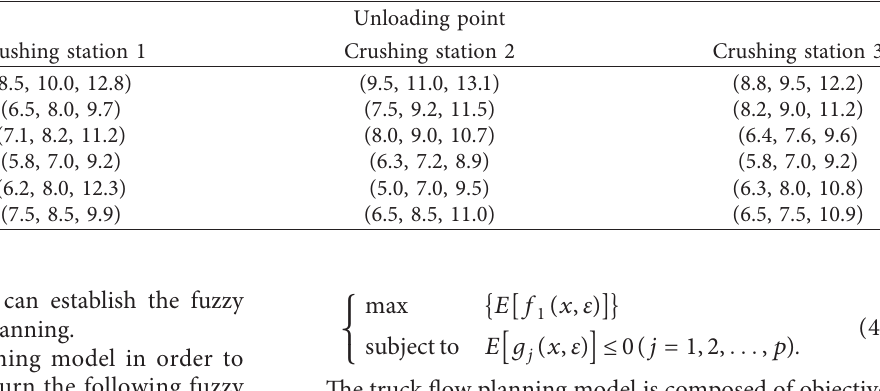
Figure 7: Scene of crushing station and receiving Table 2: Heavy truck operation data.